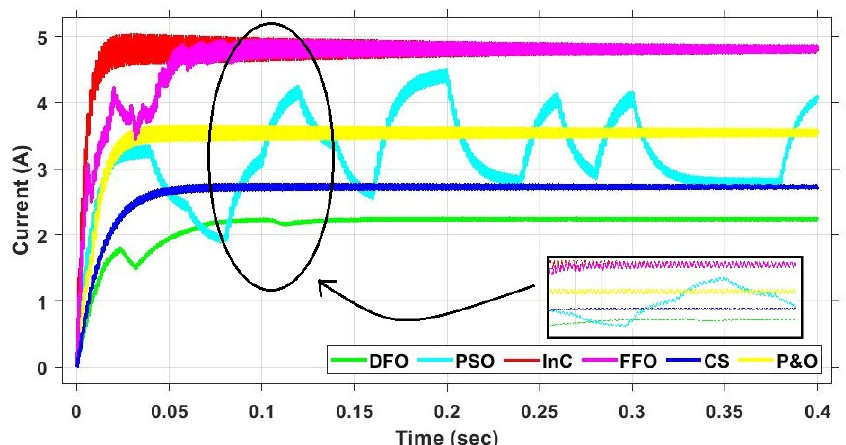
Figure 23. UI current comparison between all algorithms for centralized PV system.